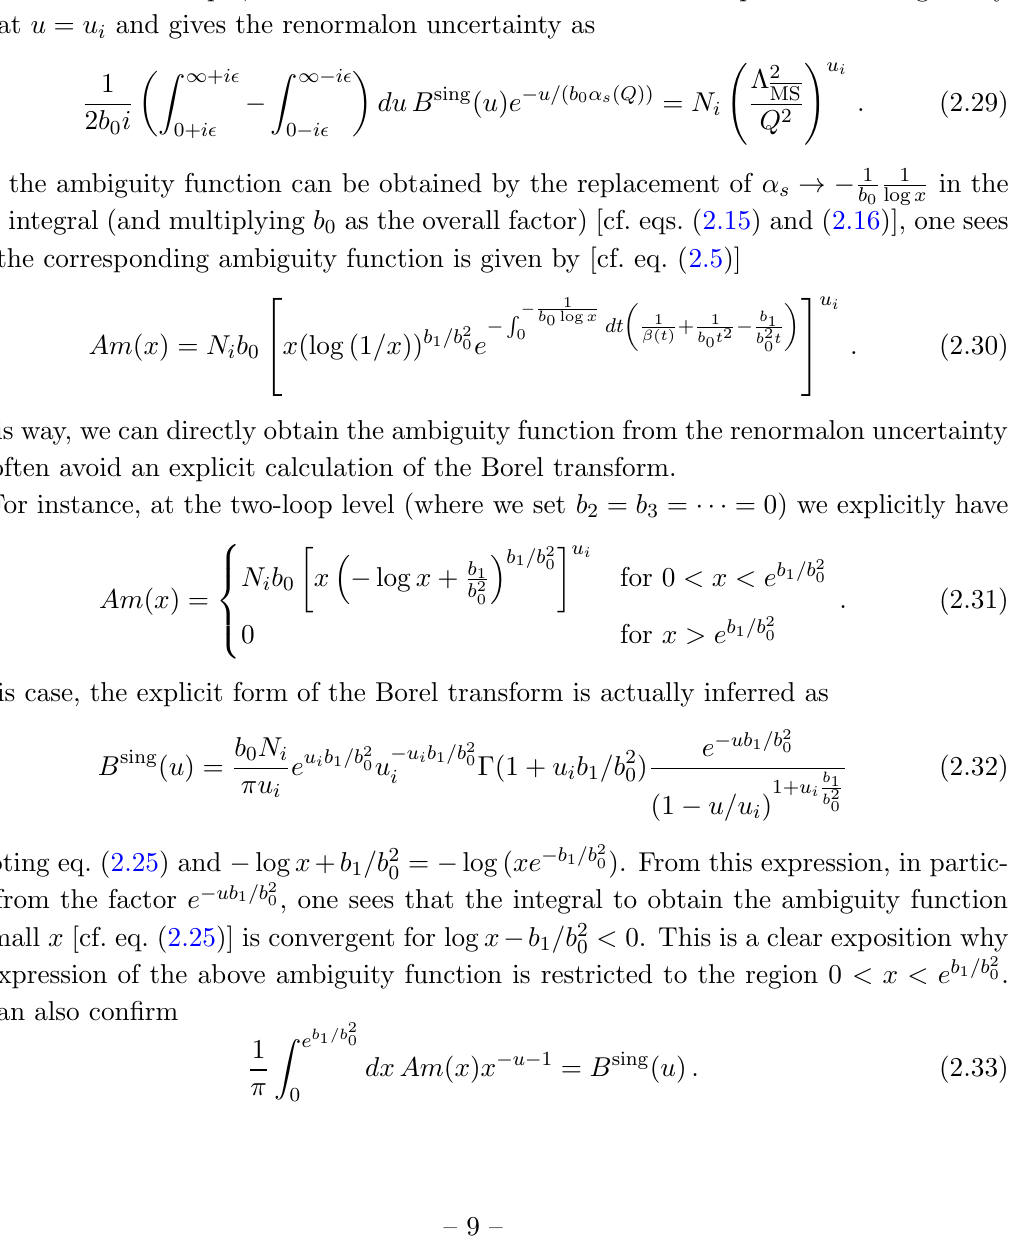
Figure 1 . Ambiguity function of eq. (2.28). The parameters are taken as b 1 =b 2 and b =